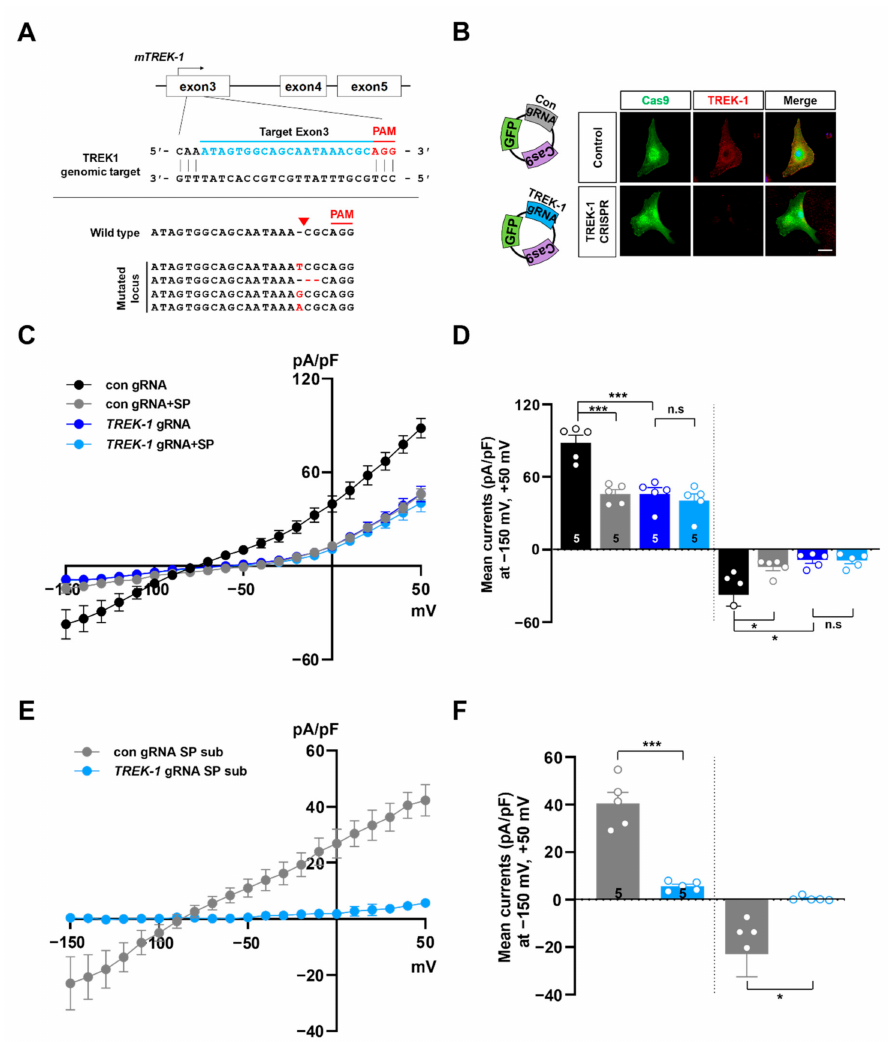
Figure 3. Spadin’s e ff ects on astrocytic K + current were abrogated by genetic ablation of TREK-1 using clustered regularly interspaced short palindromic repeats (CRISPR) / Cas9. ( A ) Schematic representation of the genomic structure of the TREK-1 gene. Target sequences of gRNA are located within exon3 of mouse TREK-1 gene. Examples of indel mutations are displayed. ( B ) Immunocytochemical images of control gRNA (Con gRNA) or TREK-1 gRNA transfected cultured astrocytes stained with anti-TREK-1 antibody. ( C ) Current densities showing before and after application of 10 µ M spadin (SP) to control gRNA or TREK-1 gRNA transfected astrocytes. ( D ) Summary bar graph of control gRNA or TREK-1 gRNA currents with or without spadin (SP) plotted at + 50 mV and − 150 mV. The number on each bar indicates n for each condition. All values are mean ± s.e.m. p -values were obtained with one-way ANOVA followed by Turkey’s post hoc test. n.s: not significant, * p < 0.05 and *** p < 0.001. ( E ) Subtract spadin (SP-sub) treatment currents from before application of spadin in control gRNA or TREK-1 gRNA transfected astrocytes. ( F ) Summary bar graph of control gRNA (Con gRNA-SP sub) or TREK-1 gRNA ( TREK-1 gRNA-SP sub) spadin-subtracted currents plotted at + 50 mV and − 150 mV. The number on each bar indicates n for each condition. All values are mean ± s.e.m. p -values were obtained with Student’s t -test. * p < 0.05 and *** p <